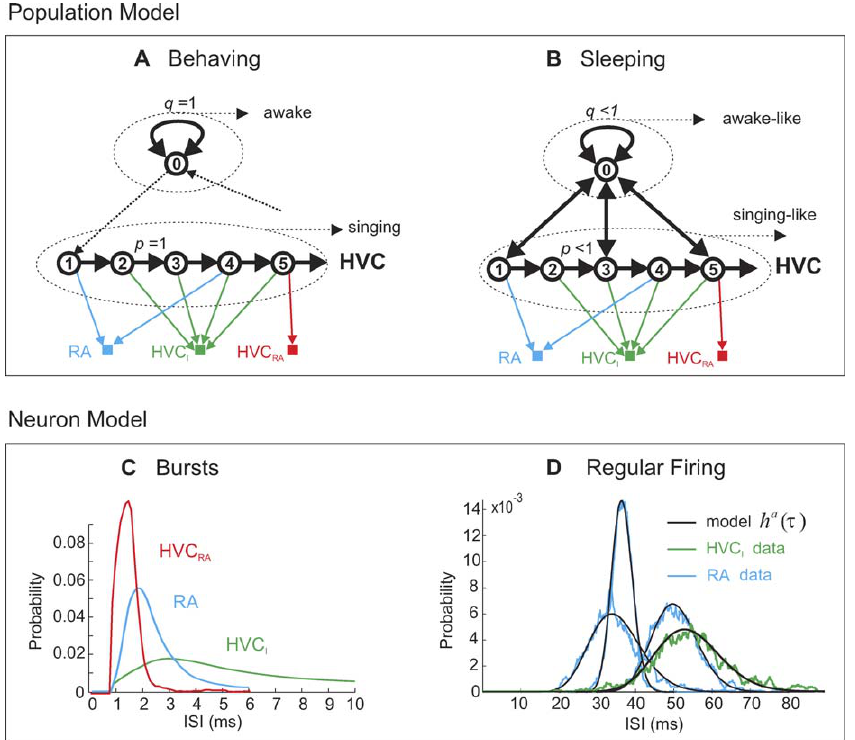
Figure 2. Markov Model of HVC Activity during Behavior and Sleep (A) When birds are awake, but not singing, HVC activity persists in a ground state (state 0) with probability q ¼ 1. When birds sing, groups of HVC RA neurons (numbered circles) are sequentially activated with probability p ¼ 1 (the dashed arrows indicate song onset and offset). A single HVC RA neuron (red square) is linked with exactly one HVC RA group, and single RA and HVC I neurons (blue and green squares) are linked with random subsets of L R and L I groups, respectively. (B) During sleep, HVC RA groups are sequentially activated with probability p , 1; with probability 1 (cid:2) p , HVC activity transits into the ground state. There, it persists with probability q , 1; with probability 1 (cid:2) q , it transits back into a song state. (C) Bursts in different neuron types are modeled by the first few milliseconds of averaged song-related ISI pdfs p b ( s ). (D) Tonic firing in RA and HVC I neurons is modeled by gamma functions p a ( s ) (black curves). The diversity of waking-related ISI pdfs in these neurons is illustrated by the blue and green curves, each representing a different neuron.